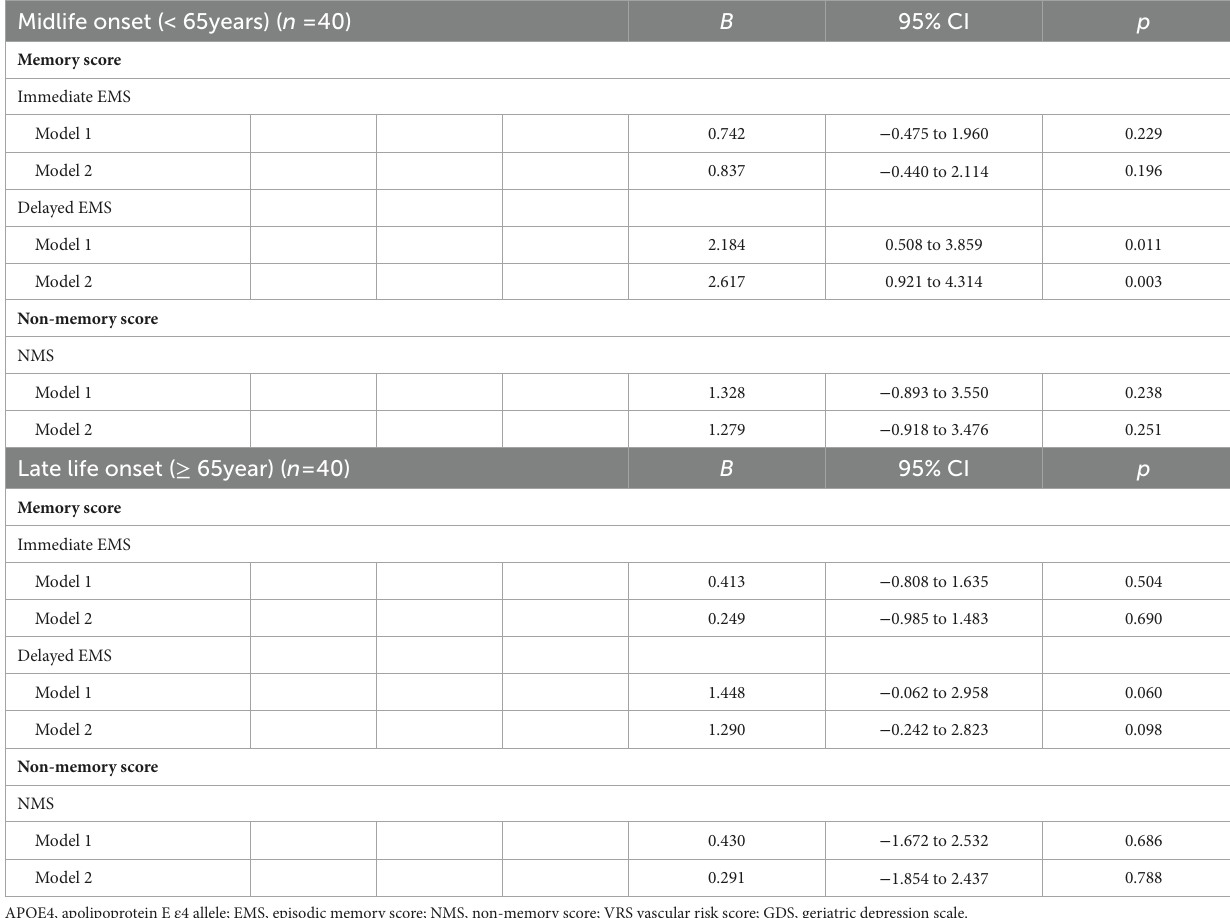
TABLE 6 Results of the multiple linear regression analyses of the association between ginseng intake status (midlife onset vs. late life onset) and cognition. Midlife onset (< 65 years) ( n =